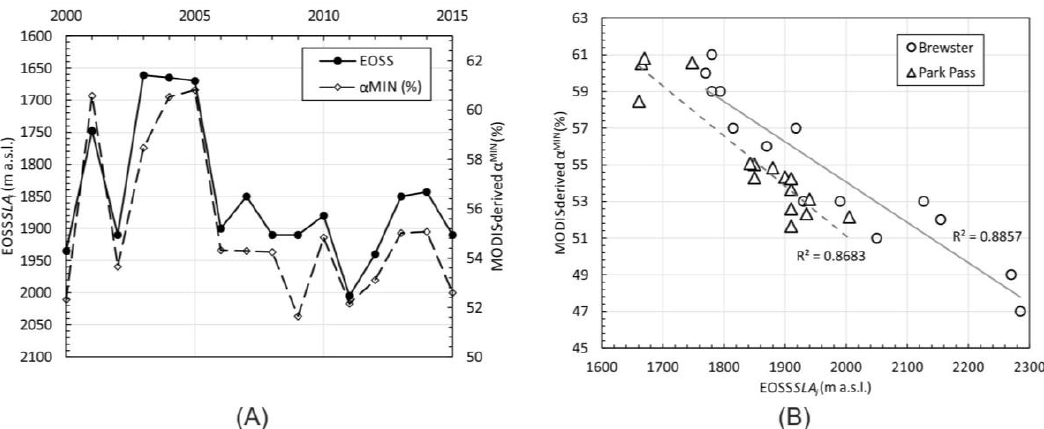
Figure 5. ( A ) Evolution of 𝛼̅ min and 𝑆𝐿𝐴 𝑖 from the snow line aerial survey program for Park Pass glacier over the 2000–2015 period; ( B ) comparative relationship between 𝛼̅ min and 𝑆𝐿𝐴 𝑖 for Park Pass and Brewster glaciers.